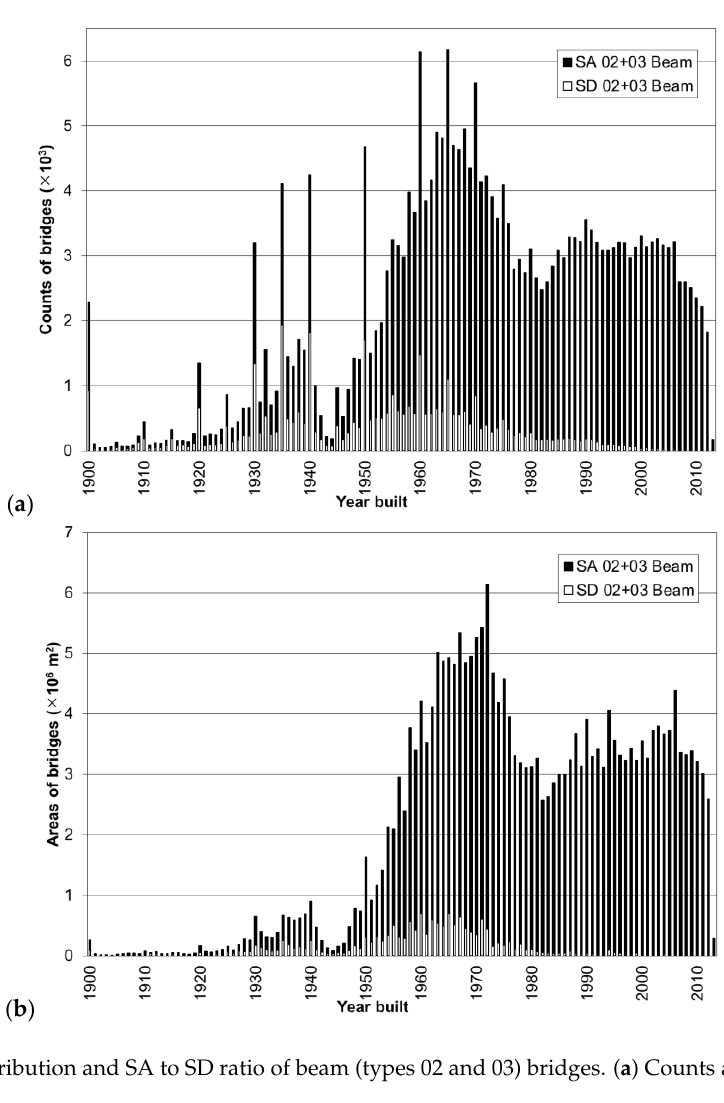
Figure 2. Distribution and SA to SD ratio of beam (types 02 and 03) bridges. (a) Counts and (b) Areas.